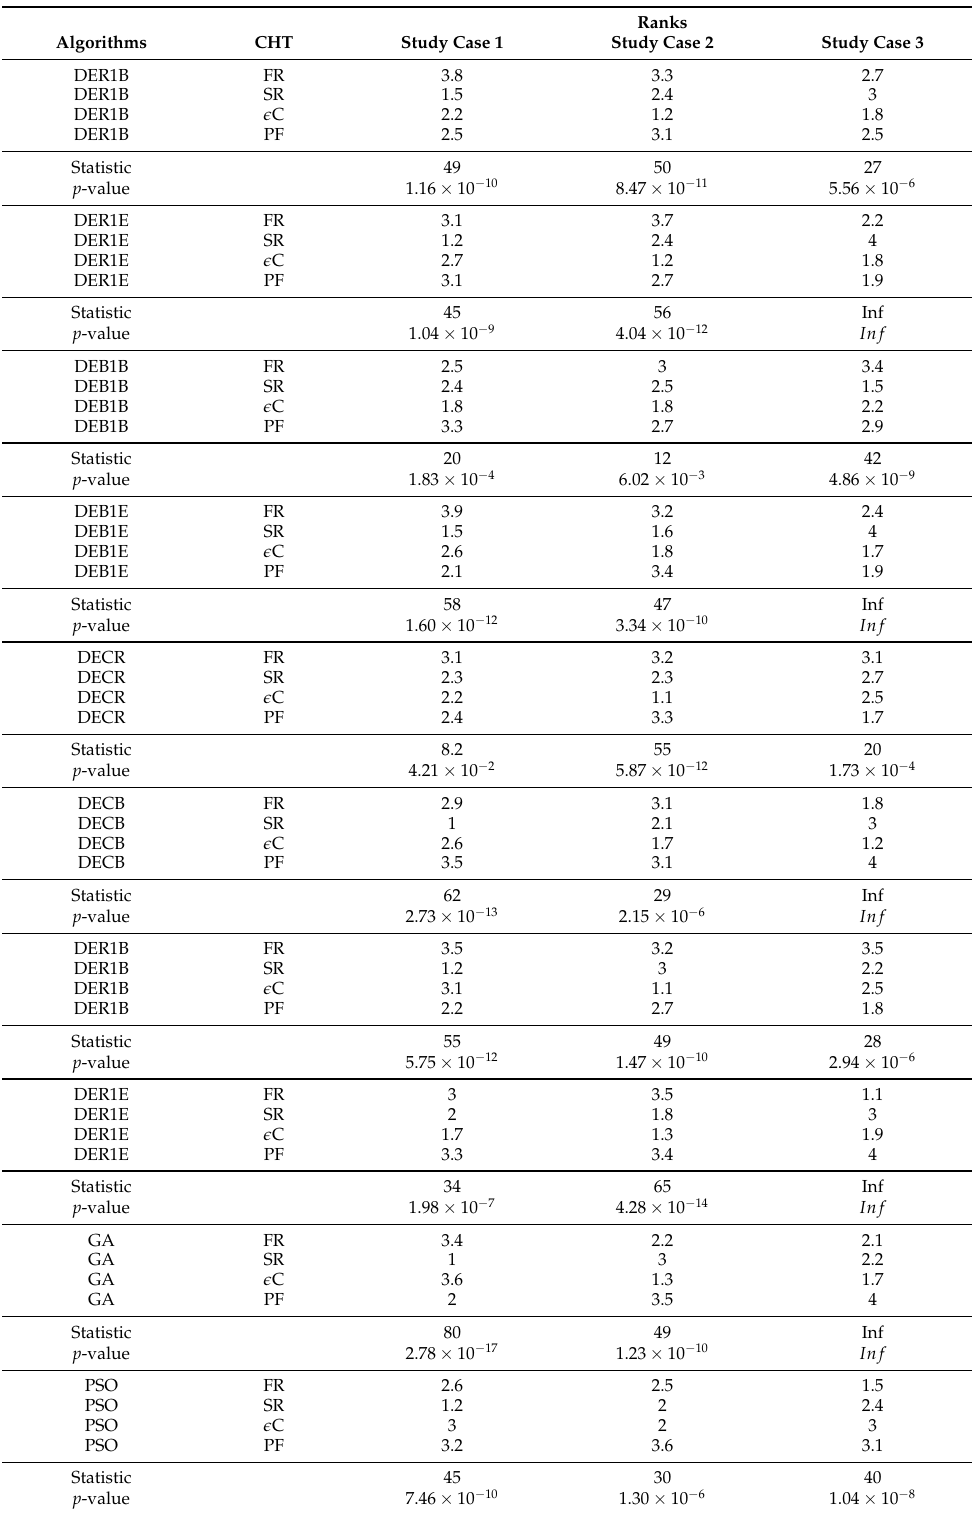
Table A24. Ranks and p -value obtained by the Friedman test for the PR metric. A p -value less than 0.05 indicates that at least two groups of values for each algorithm are